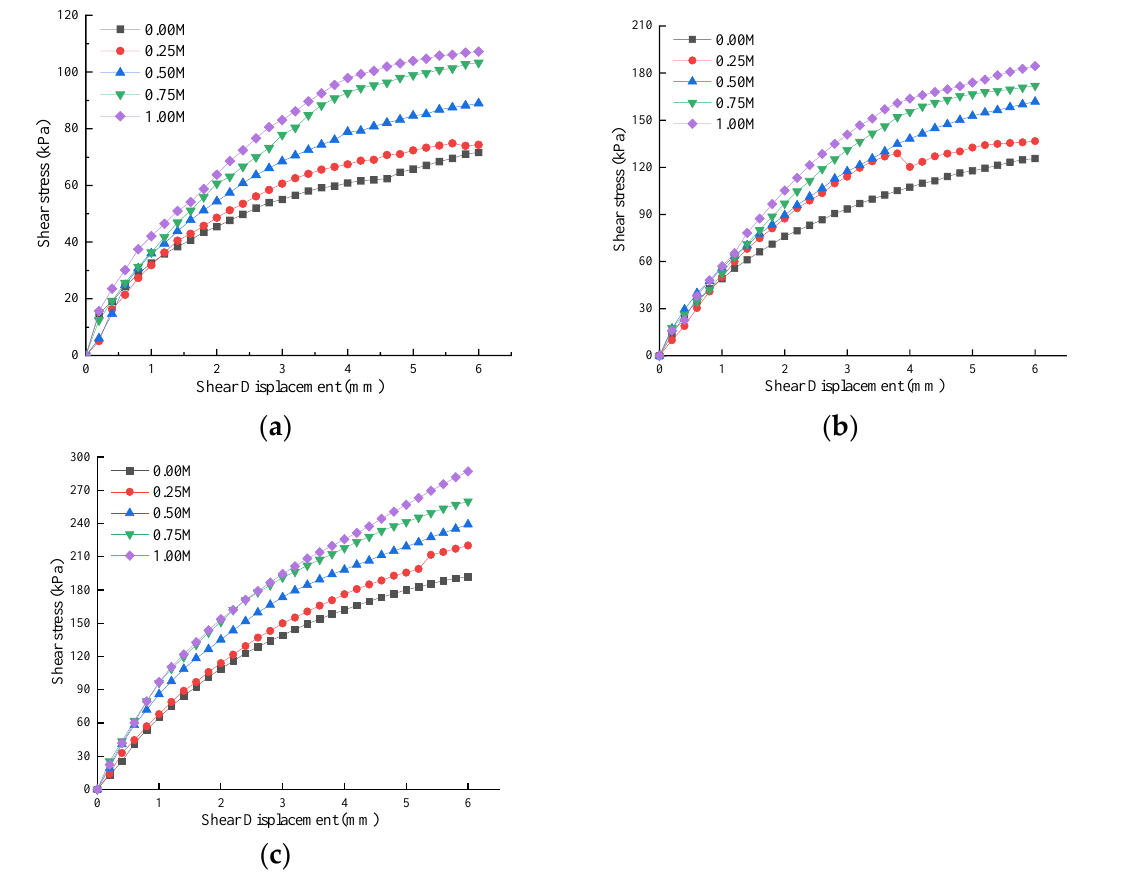
Figure 6. Shear stress and displacement curve: ( a ) 100 kPa; ( b ) 200 kPa; ( c ) 300 kPa.